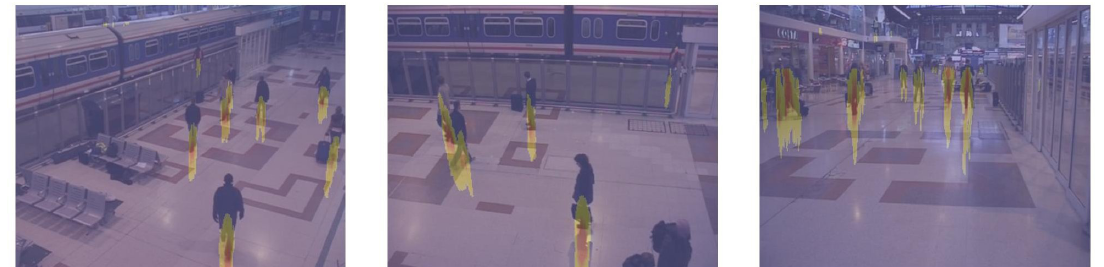
Fig. 4. Results of background subtraction superposed on top of the original images of 3 cameras [16].